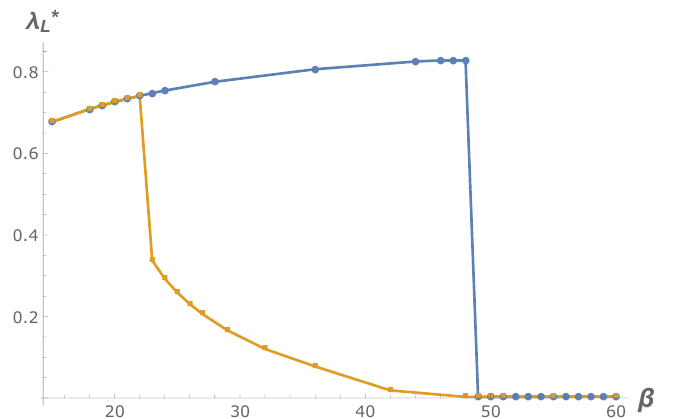
Figure 6. Normalized Lyapunov exponent in the two di(cid:11)erent phases for (cid:17) = 0 : 27. The blue curve corresponds to the cooling process starting from the chaotic phase. The orange curve corresponds to the heating process starting from the integrable phase. Note that the Lyapunov exponent of the integrable phase is non-zero inside the hysteresis loop.